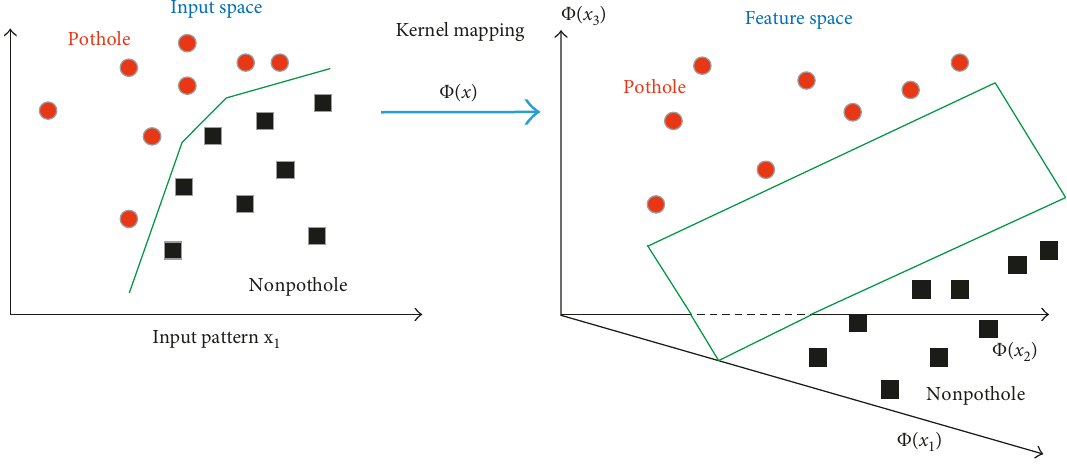
Figure 5: The LS-SVM classification model’s learning